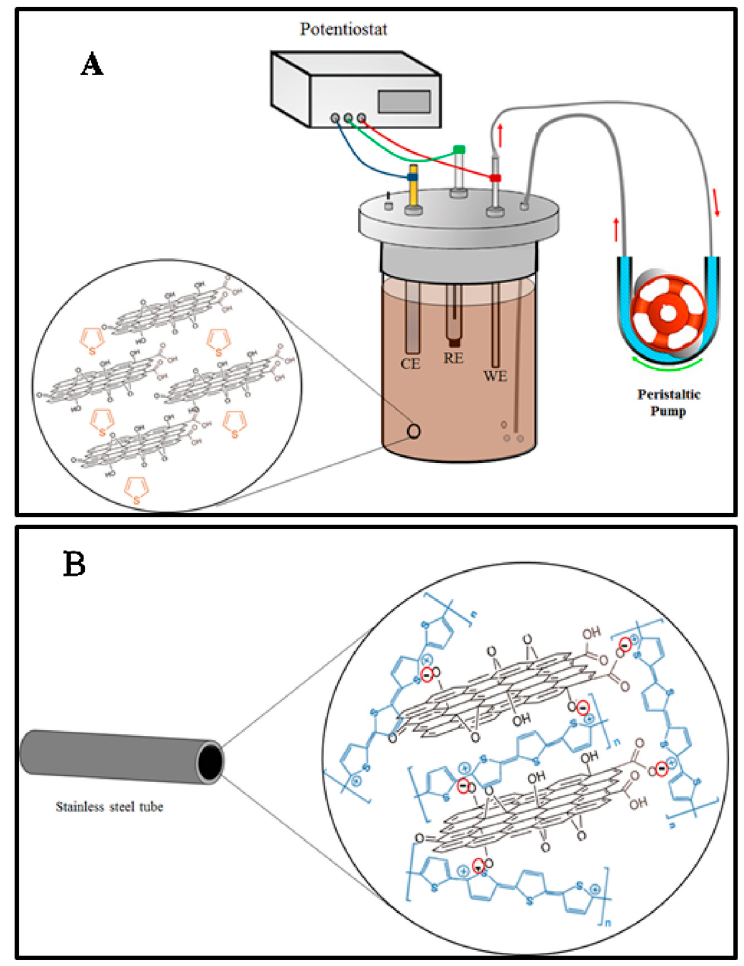
Figure 3. ( A ) Schematic representation of the fabrication process of a polythiophene/graphene (PTh/GO) nanostructured electrodeposited coating using a peristaltic pump. ( B ) Internal surface of stainless steel tube after coating. Adopted from [103] with permissions.